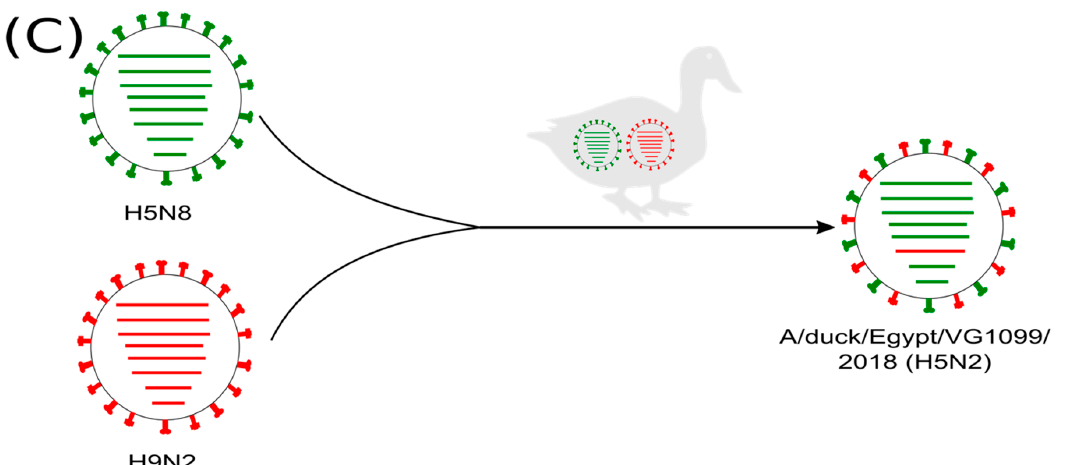
Figure 1. Phylogenetic trees of the nucleotide sequences of the HA ( A ) and NA ( B ) gene segments. Maximum likelihood calculations were done using the IQTree software under the best fit model according to the Bayesian criterion. Egyptian H5N2 virus is indicated with a black dot. ( C ) Emergence